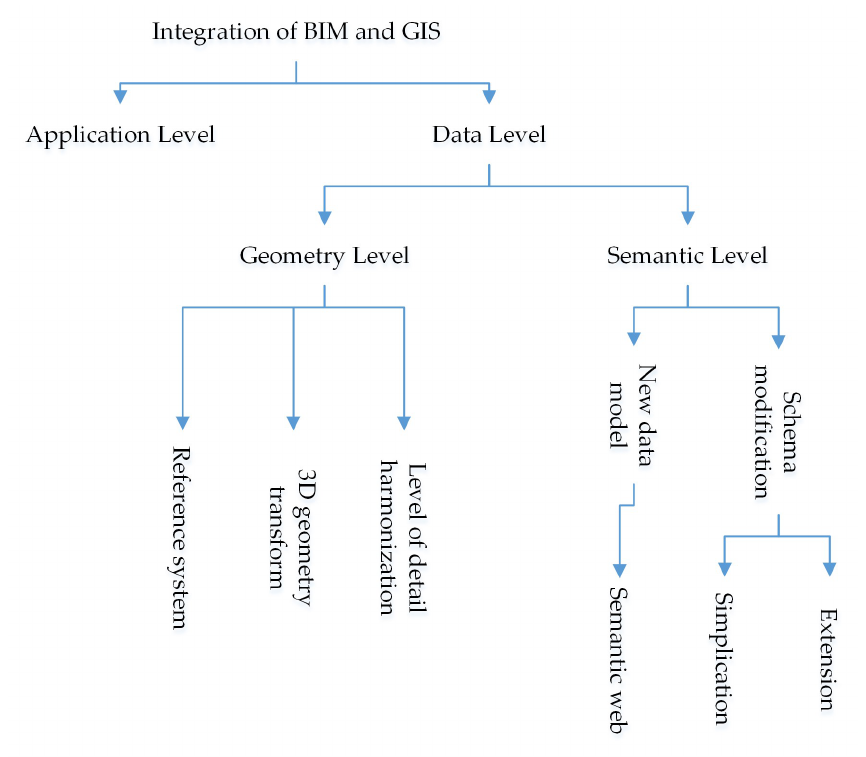
Figure 4. Levels of integration of BIM and